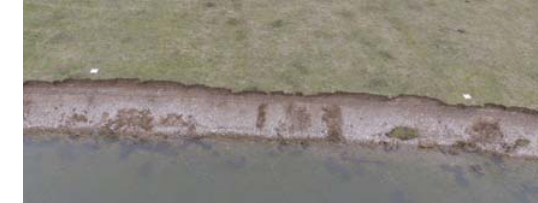
Figure 3: Bank morphology and coded targets as